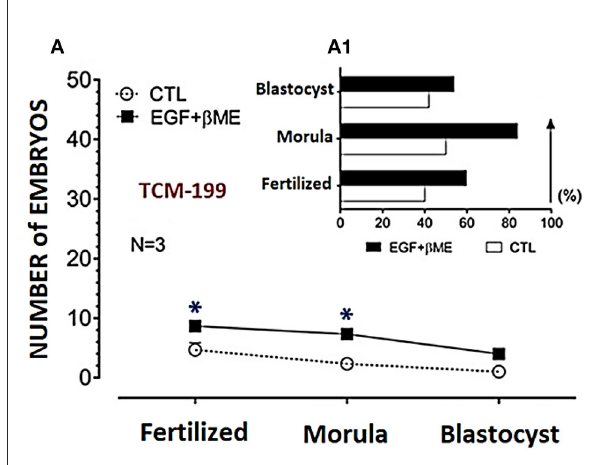
FIGURE4 Effects of combined supplementation of EGF (20ng/mL) and β ME (50 µ M) to the TCM-199 medium on the buffalo embryo stages; fertilized oocytes, morula, and blastocyst, were shown in (A) , and the trend demograph for the blastocyst production was shown in (A1) . Asterisk ( * ) denotes significance difference between each respective values (treated vs. CTL) at P < 0.05.